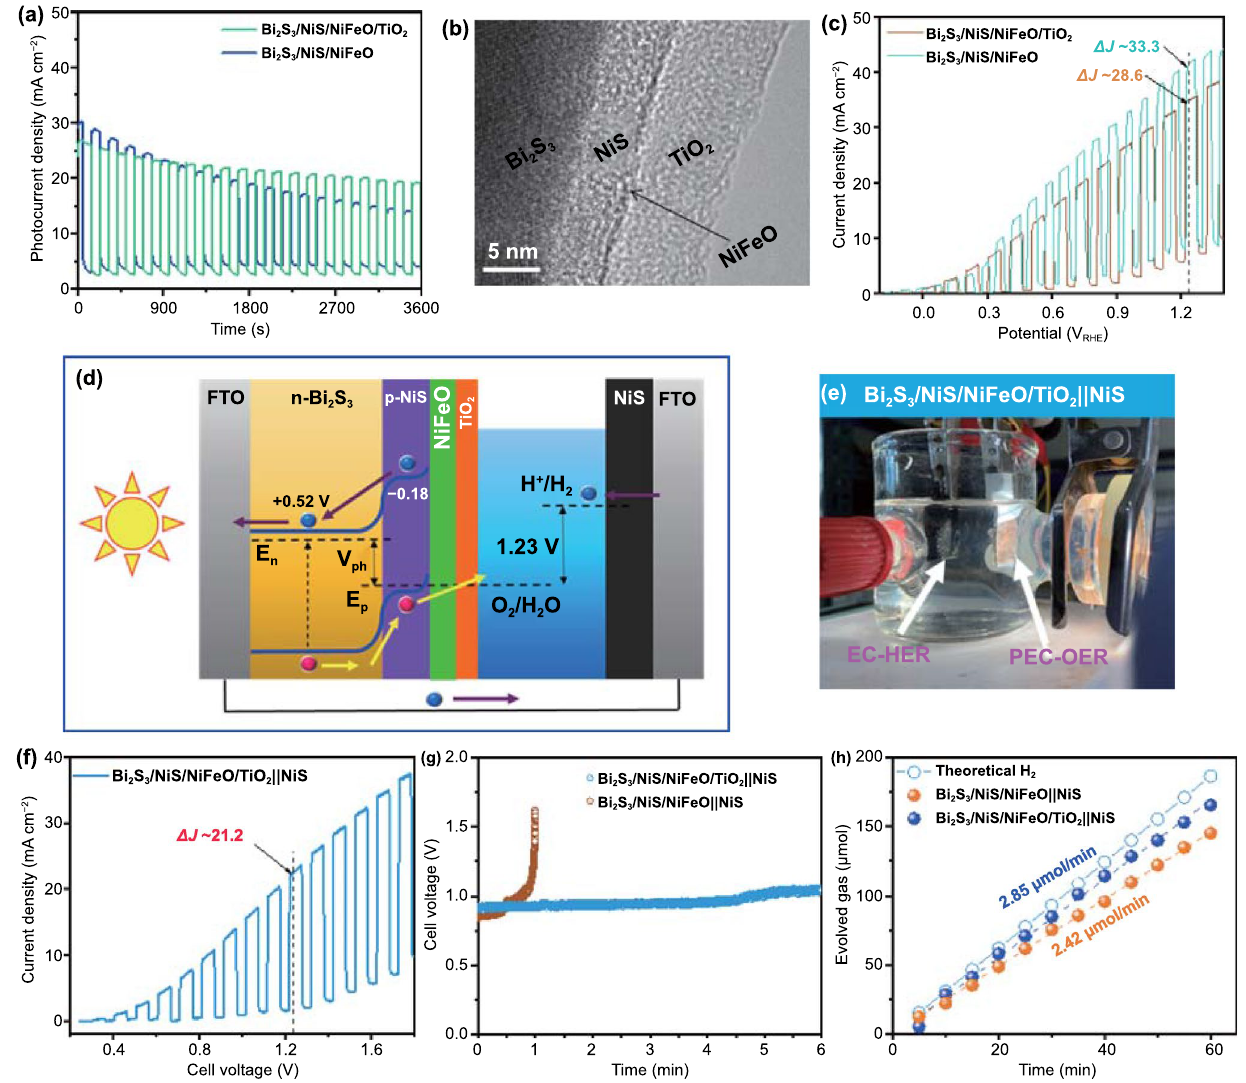
J – V curves before and after addition of TiO 2 photoanode, c 2 buffer layer, d, e two‑electrode PEC‑EC cell configuration with Bi 2 S 3 / NiS/NiFeO/TiO 2 and NiS as photoanode and electrocathode, respectively, f J – V curve and g J – T curve of PEC‑EC cell, h comparison of experi‑ mental H 2 evolution at a current density of 10 mA cm